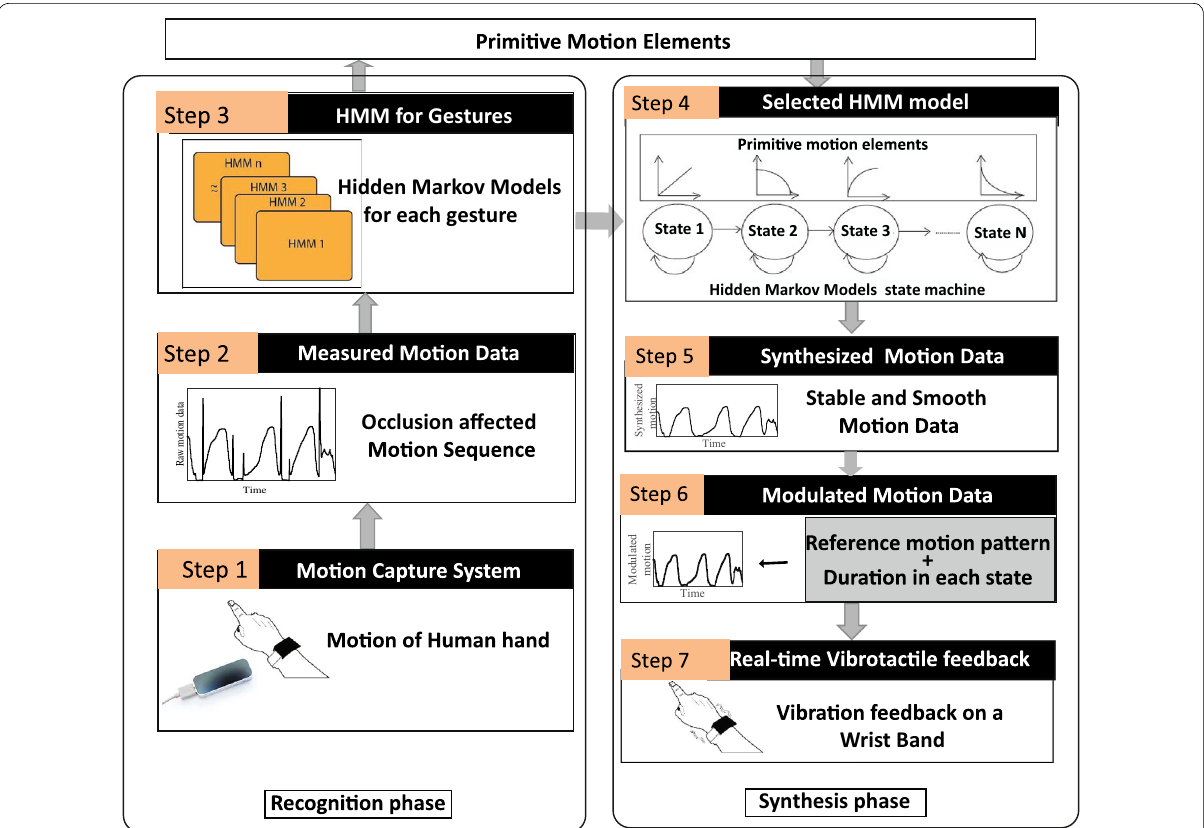
Fig. 1 Proposed motion synthesis model. The seven-step motion synthesis model based on HMM for gesture recognition and subsequent motion control element